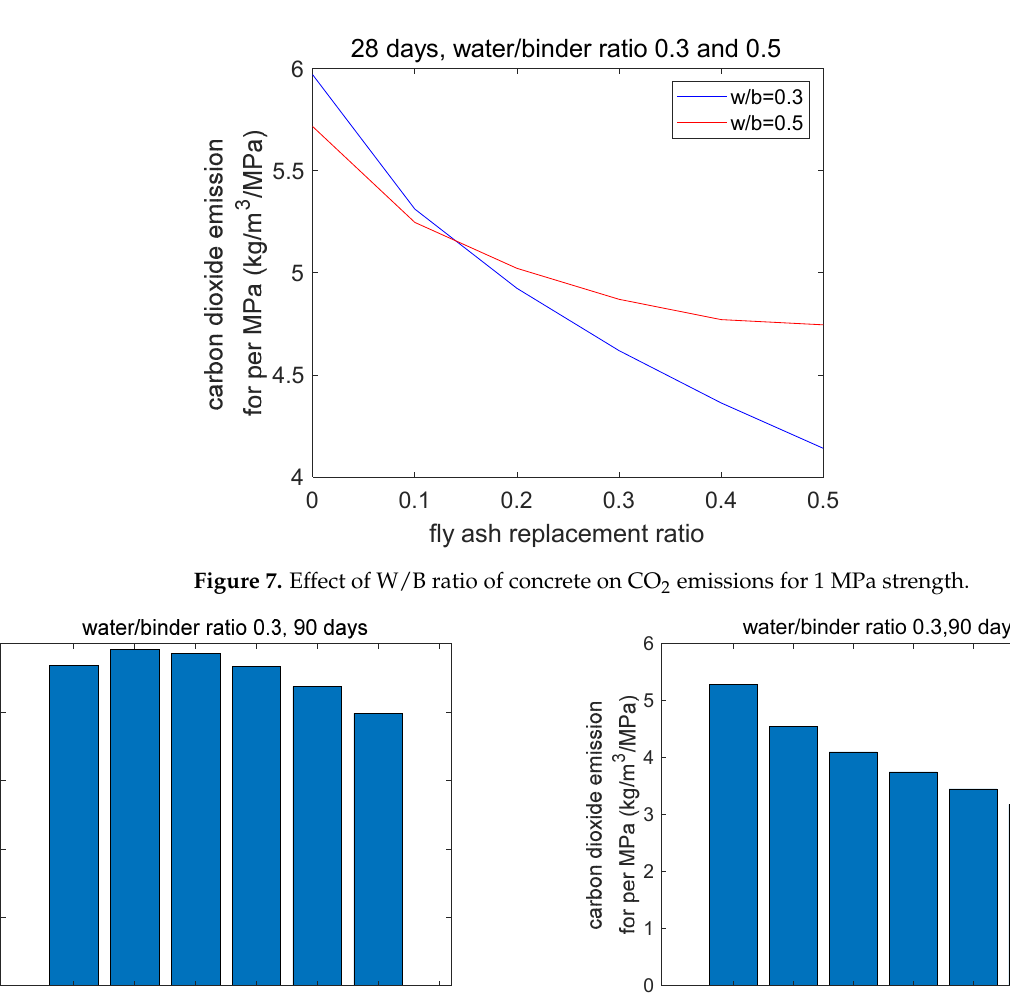
Figure 6. CO 2 emissions for composite concrete with W/B ratio = 0.3 at 28 days. ( a ) Strength at 28